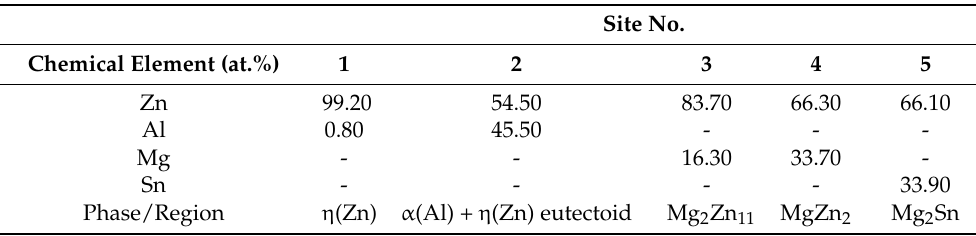
Figure 2. Selected features of MZ + 0.0Sn alloy microstructure after DSC measurement: ( a ) example of ternary eutectic; ( b ) example of binary eutectic; ( c ) example of Mg 2 Zn 11 and MgZn 2 mixture; ( d ) area with EDS measurement points 1 – 4 listed in Table 2. Table 2. EDS chemical composition of selected sites (at.%).